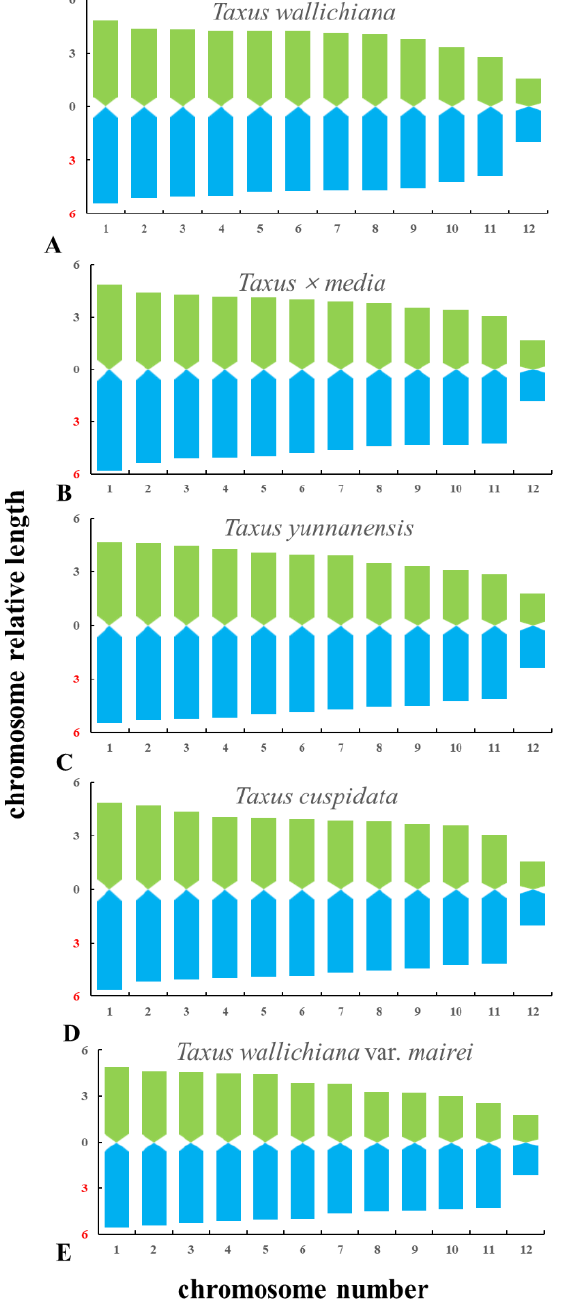
Figure 4. Karyotype idiograms of five Taxus species. ( A ) T. wallichiana , ( B ) T. × media , ( C ) T. yunnanensis , ( D ) T. cuspidate, and ( E ) T. wallichiana var. mairei. The x-axis indicates the chromosome number, whereas the y-axis indicates the relative chromosome